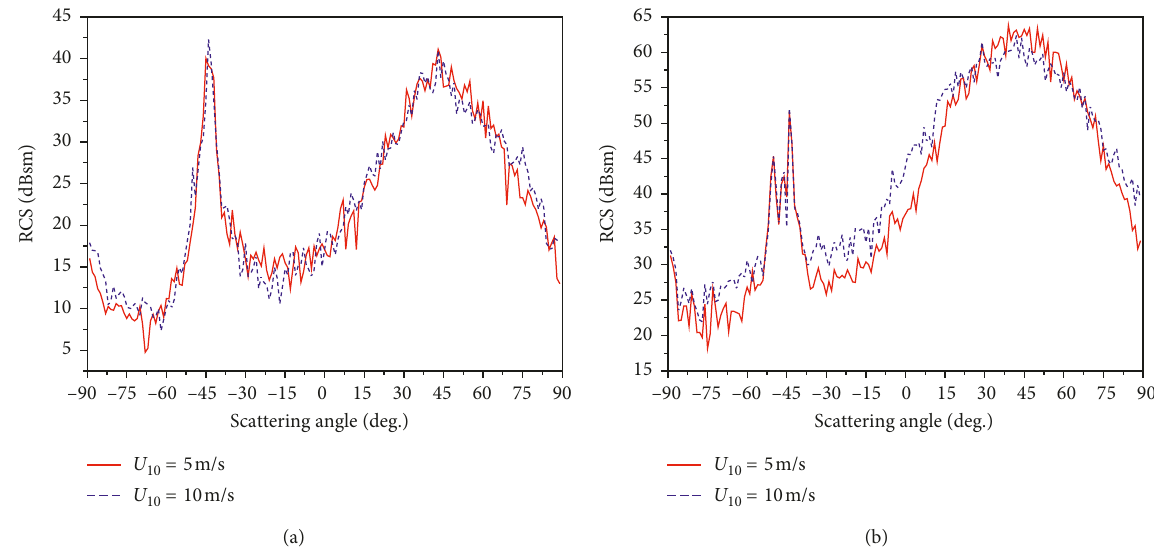
Figure 15: The change of RCS of coupling field and total field from the ship and sea surface with different wind speeds. (a) Coupling field. (b) Total field.